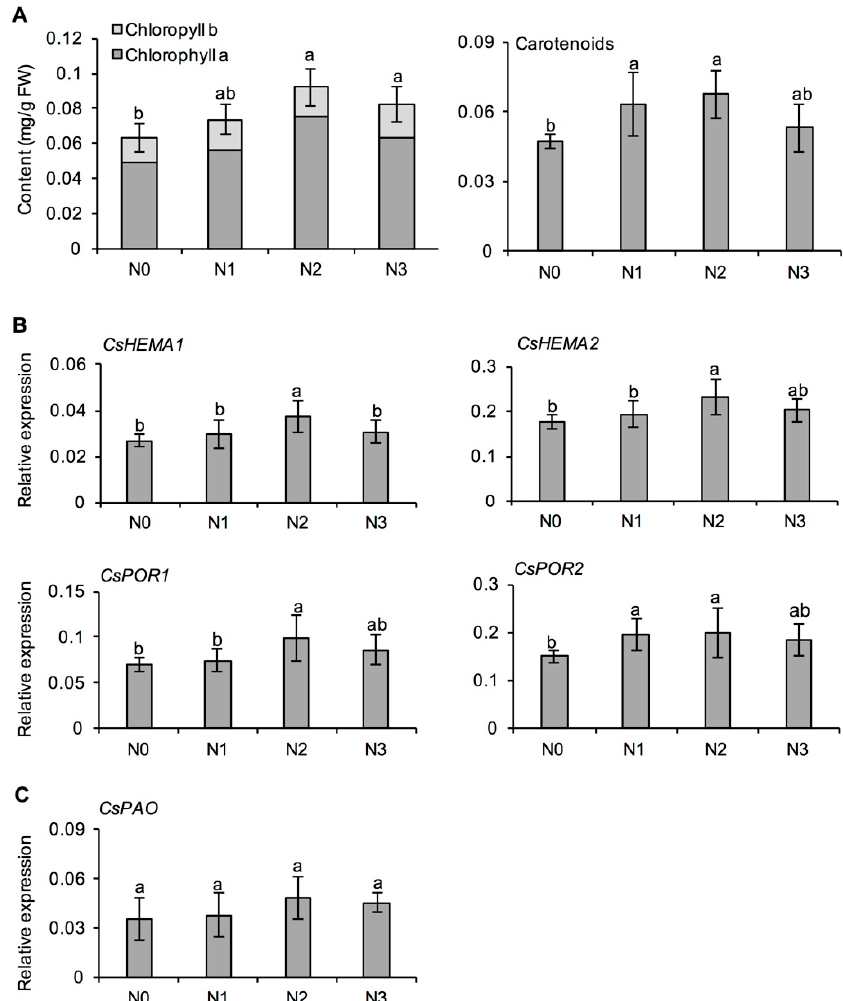
Figure 1. Effects of long-term nitrogen application on the content of chlorophyll and carotenoids ( A ), and expression of key genes for chlorophyll synthesis ( B ), and degradation ( C ) in fresh tea leaves collected in spring. HEMA : glutamyl-tRNA reductase ; POR : protochlorophyllide oxidoreductase ; PAO : pheophorbide a oxygenase . The nitrogen application treatments indicate N0: 0 N kg/hm 2 ; N1: 112.5 N kg/hm 2 ; N2: 225 N kg/hm 2 ; N3: 450 N kg/hm 2 , respectively. Values followed by different letters (a and b) mean significant at the 5% level among different treatments.